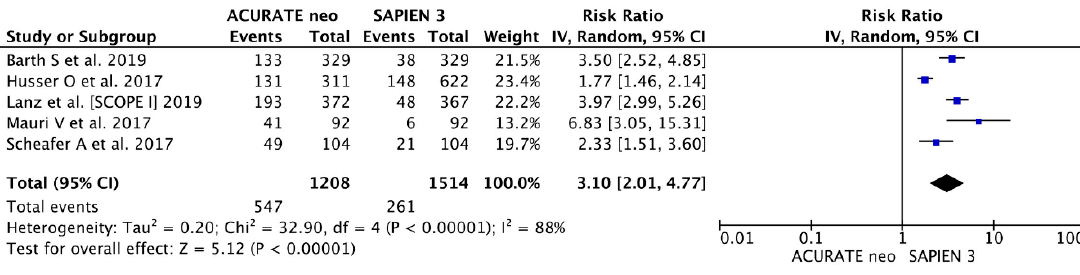
Figure A1. Procedural outcomes. Individual and summary risk ratios with corresponding 95% confidence intervals for the comparison of ACURATE neo vs. SAPIEN 3 in the analysis of predilatation.